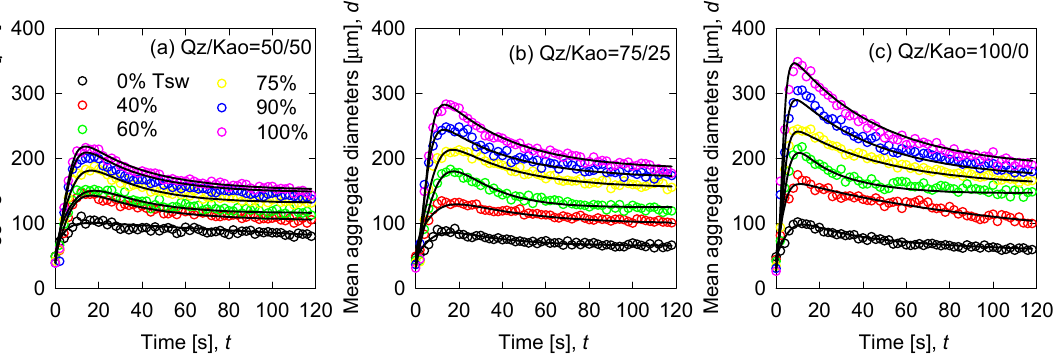
Figure 2. Experimental (symbol) vs. calculated (lines) evolution of the aggregates at varied proportions of quartz/kaolin (Qz/Kao) and treated seawater (Tsw). Solid concentration 13 wt%, flocculant dose 15 g/t, mixing intensity 188 s − 1 . Quartz/Kaolinite ratio ( a ) 50/50; ( b ) 75/25; ( c ) 100/0. This course is repeated for the three types of synthetic tailings, which vary in clay